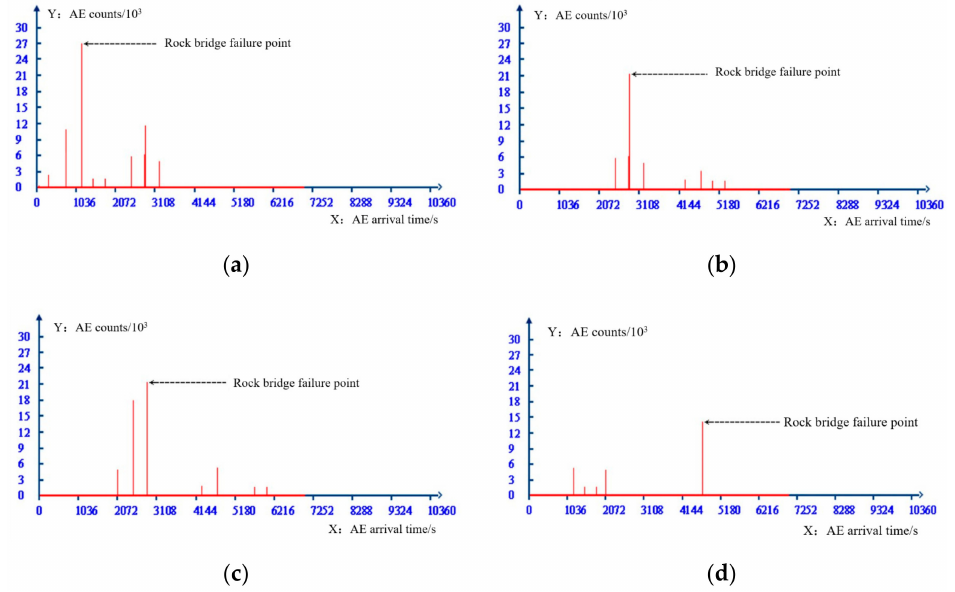
Figure 19. AE arrival time and AE counts under di ff erent joint continuity rates. ( a ) Joint continuity rate is 0.8, ( b ) Joint continuity rate is 0.6, ( c ) Joint continuity rate is 0.4, ( d ) Joint continuity rate is